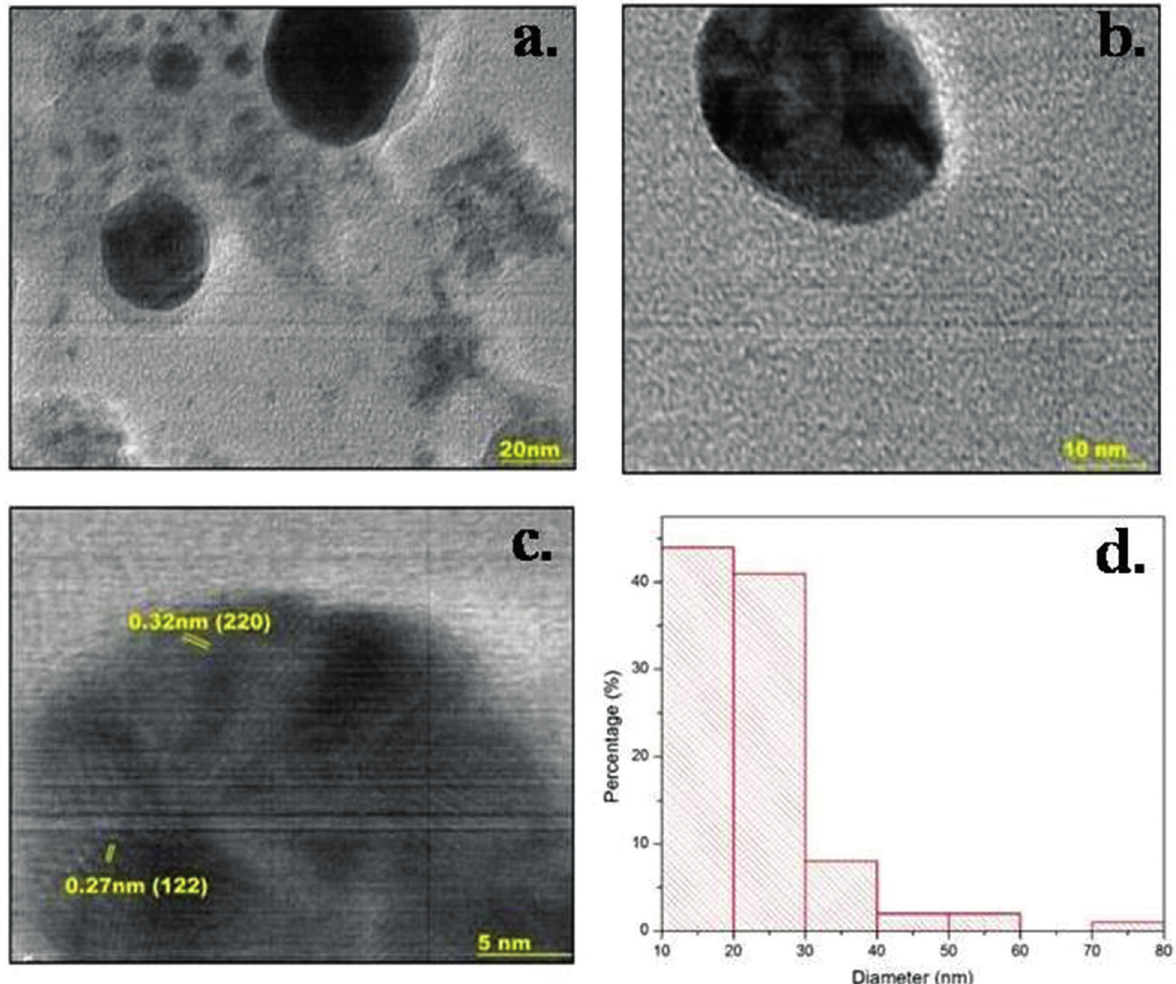
Figure 5: HRTEM images and histogram of silver